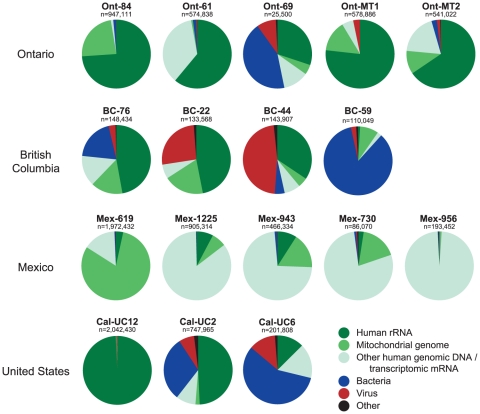
Metagenomic analysis of 2009 H1N1 samples by deep sequencing.Pie charts depicting the number and distribution of sequence reads for each sample. Deep sequencing reads were successively aligned to human rRNA (dark green), human mitochondrial genomic DNA (medium green), other human genomic DNA/transcriptomic RNA (light green), and the non-redundant nucleotide (NT) database, containing bacterial (blue), viral (red), and “other” (black) sequences. Reads designated as “other” consisted solely of artificial plasmids or environmental sequences.